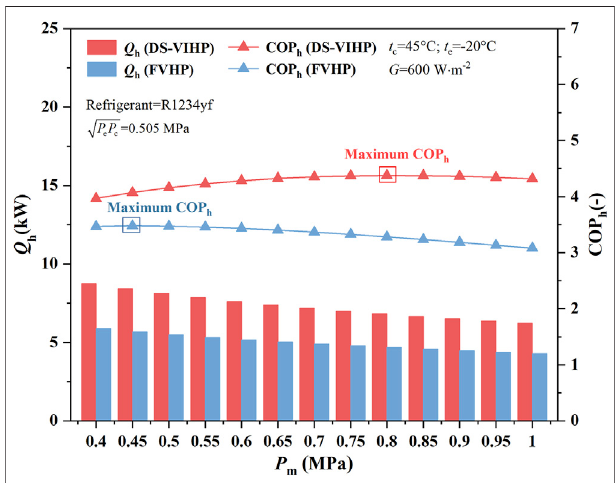
FIGURE4| Performancevariationsoftwosystemswiththeintermediate pressure.